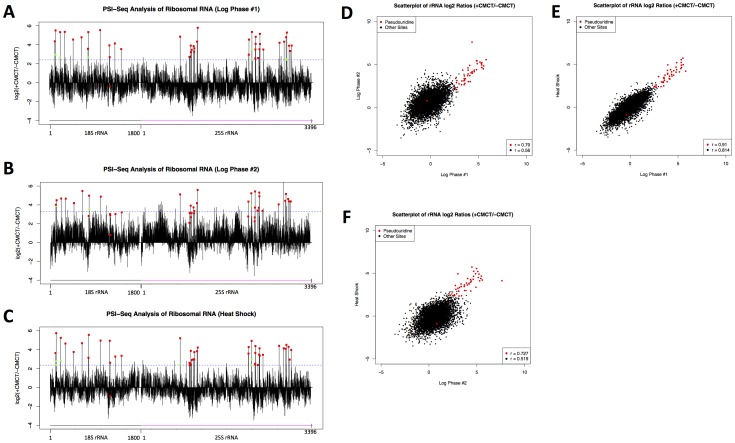
PSI-Seq Identifies Known Pseudouridine Sites in Yeast Ribosomal RNA.For each nucleotide in 18S and 25S rRNA, the log2 ratio of the number of reads (plus one) stopping at that position in the +CMCT library versus the –CMCT (mock) library was plotted. The dashed blue line indicates the cutoff for the top 60 sites in each condition, which includes all 43 known pseudouridine sites (red squares) that are not further modified. Sites among the top 60 that were located exactly one away from known pseudouridines, representing “secondary stops”, are marked with green circles. The data are plotted for yeast RNA isolated from both log phase (A–B) and heat shock (C) conditions. Scatterplots of the log2 ratios shown in (A–C) are displayed for pairwise comparisons to assess reproducibility of values for known pseudouridines (red) and all sites (black) between independent experiments (D–F).